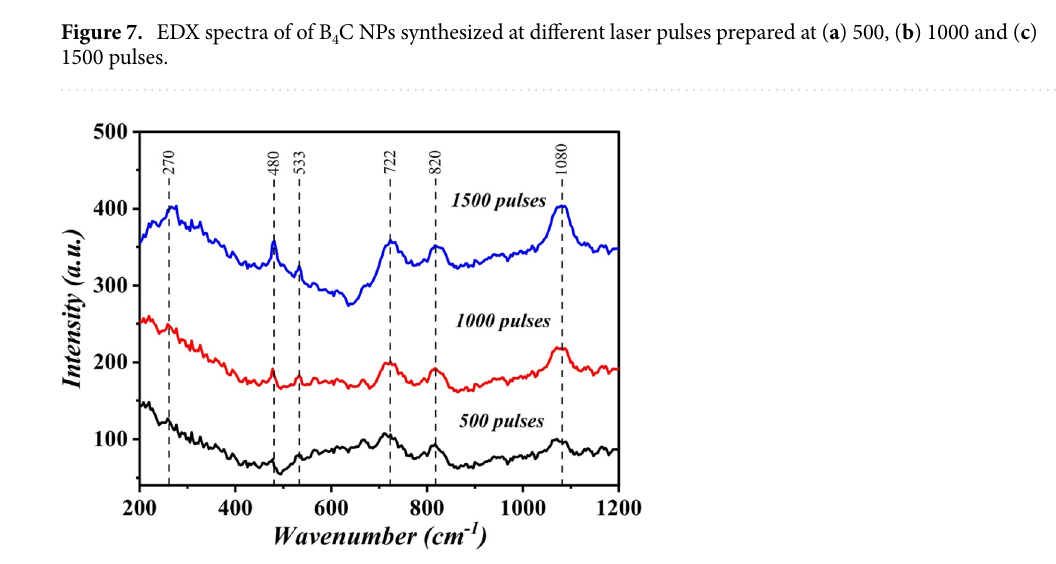
Figure 8. Raman spectra of B 4 C NPs synthesized at different laser